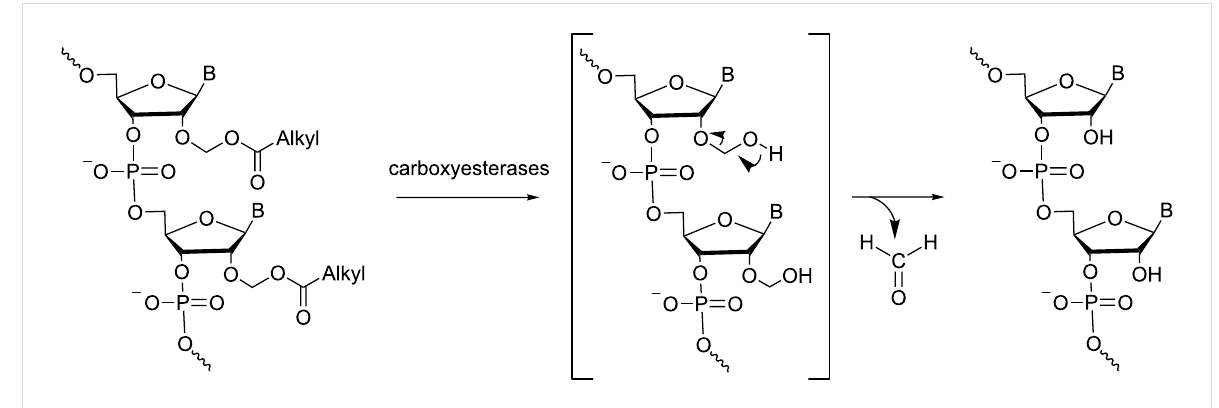
Scheme 10: Mechanism of the hydrolysis of 2’- O -acyloxymethyl ONs mediated by carboxyesterases [46]. The hydrolysis of the ester functions yields an unstable 2’-hemiacetal, affording the free RNA through the release of